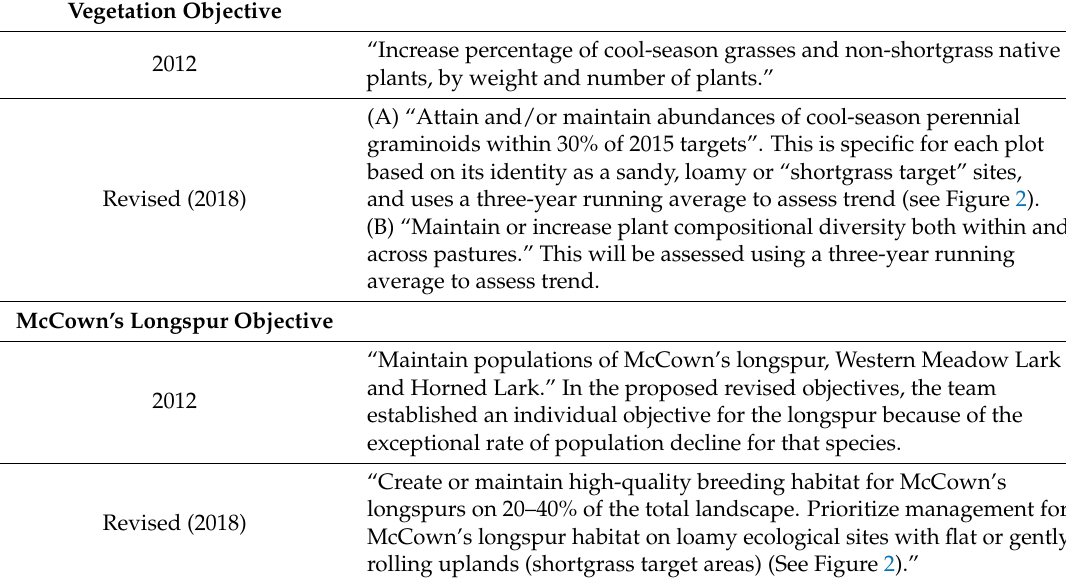
Table 1. Management objectives for the CARM group in 2012 and following revisions in 2018. Additional rationale and metrics are included in Supplement